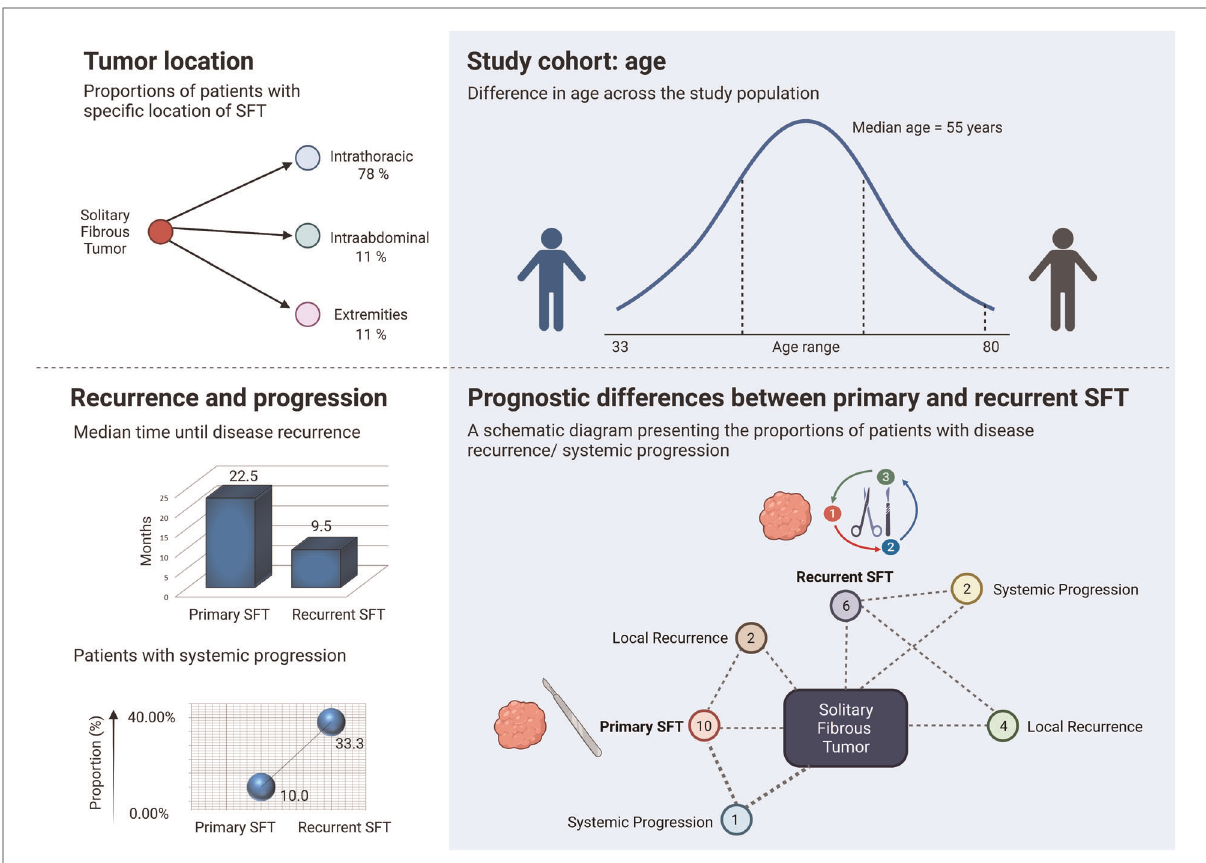
FIGURE 2 Prognostic variables and selected observations of the study cohort. The upper left section is a schematic diagram presenting the proportions of patients with intrathoracic (78%), intra-abdominal (11%), and limb location (11%) of solitary fi brous tumor (SFT). The upper right section presents the age range and age median of the study cohort. The lower left section shows that systemic progression of the disease was observed in 33.33% of patients who underwent surgery for recurrent SFT and in 10% of patients with newly diagnosed SFTs. Patients that were admitted and operated on for recurrent SFT tended to relapse earlier. The lower right section is a schematic diagram presenting the number of patients with disease recurrence/systemic progression. Out of 10 patients surgically treated for primary SFT, 2 (20%) patients developed local recurrence, and 1 (10%) patient presented with the systemic progression of the disease. Out of 6 patients who were admitted and operated on at our department for local recurrence of SFT, 4 (66.67%) patients presented with another episode of local SFT recurrence after being surgically treated, and 2 (33.33%) patients developed